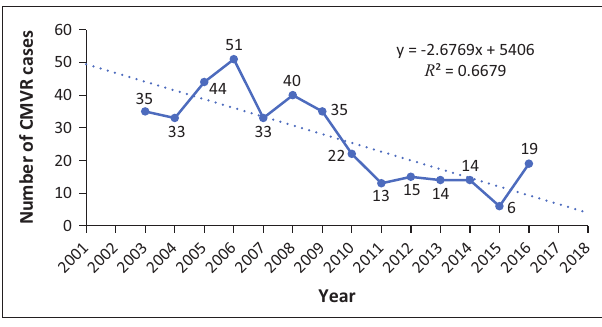
Key: Blue = linear trend model; black = observed trend. FIGURE 4: Number of new cases of cytomegalovirus retinitis diagnosed per year from 01 January 2003 to 31 December 2016 at Inkosi Albert Luthuli Hospital a large public ophthalmology healthcare centre managing the greater number of cytomegalovirus retinitis in KwaZulu-Natal, South